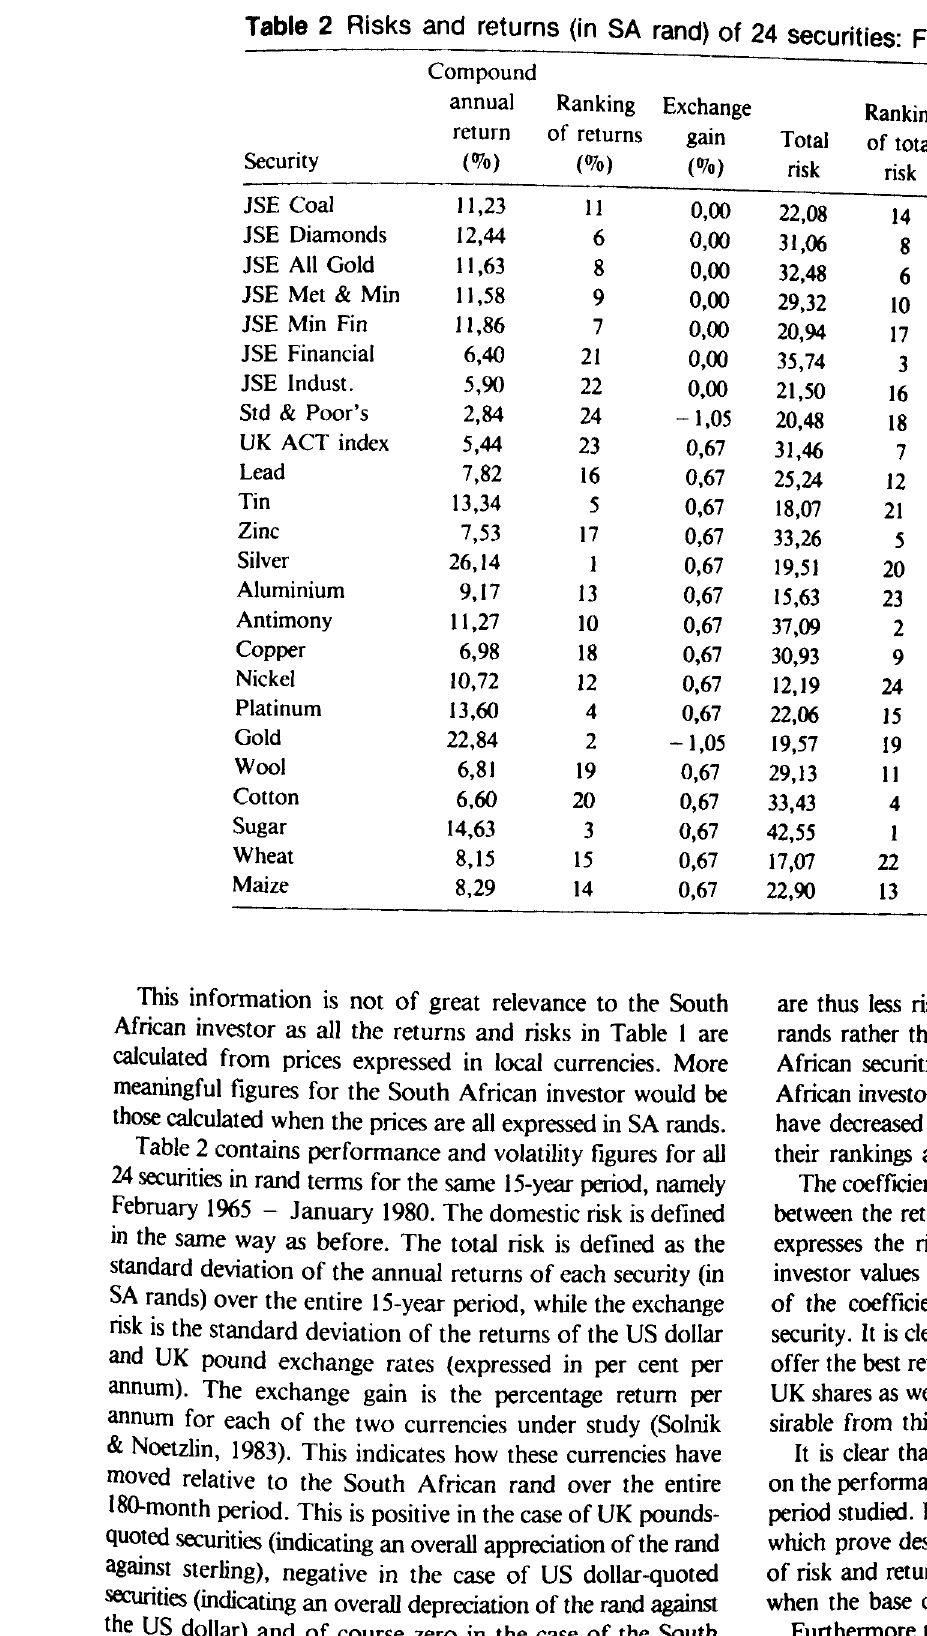
Table 2 Risks and returns (in SA rand) of 24 securities: February 1965 to January